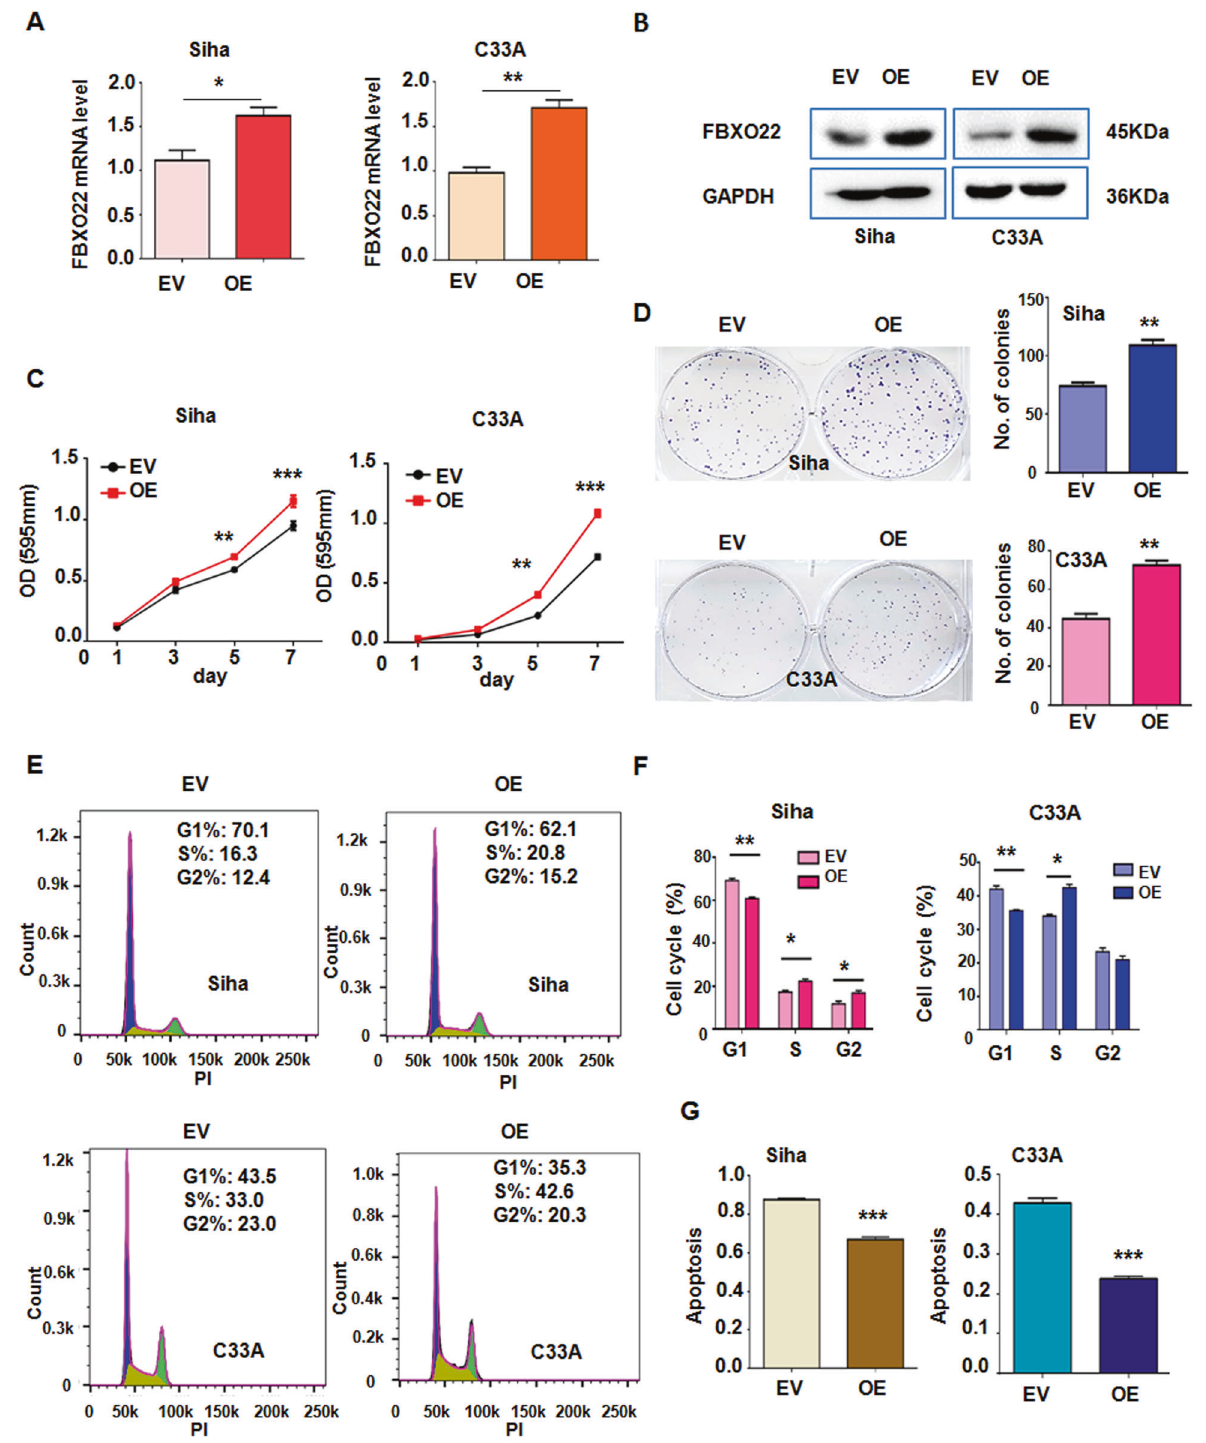
Fig. 3 Ectopic expression of FBXO22 promotes cell growth and G1/S phase progression, and inhibits cell apoptosis. A , B The mRNA levels ( A ) and protein levels ( B ) of FBXO22 were detected in FBXO22 overexpressing (OE) or empty vector (EV)-transfected SiHa and C33A cells. GAPDH level was used as a loading control. FBXO22 mRNA level in panel A is the means ± SEM from triplicate measurements. * P < 0.05, ** P < 0.01. C , D Overexpressed FBXO22 promoted viability ( C ) and colony formation ( D ) of SiHa and C33A cells. Each data point is means ± SEM from triplicate measurements. ** P < 0.01, *** P < 0.001. E , F Overexpression of FBXO22 accelerated G1 to S phase cell cycle progression. Each data point is means ± SEM from triplicate measurements. * P < 0.05, ** P < 0.01. G Overexpression of FBXO22 suppressed the apoptosis of SiHa and C33A cells. Each data in the plots are presented as the means ± SEM from triplicate measurements. *** P < 0.001.